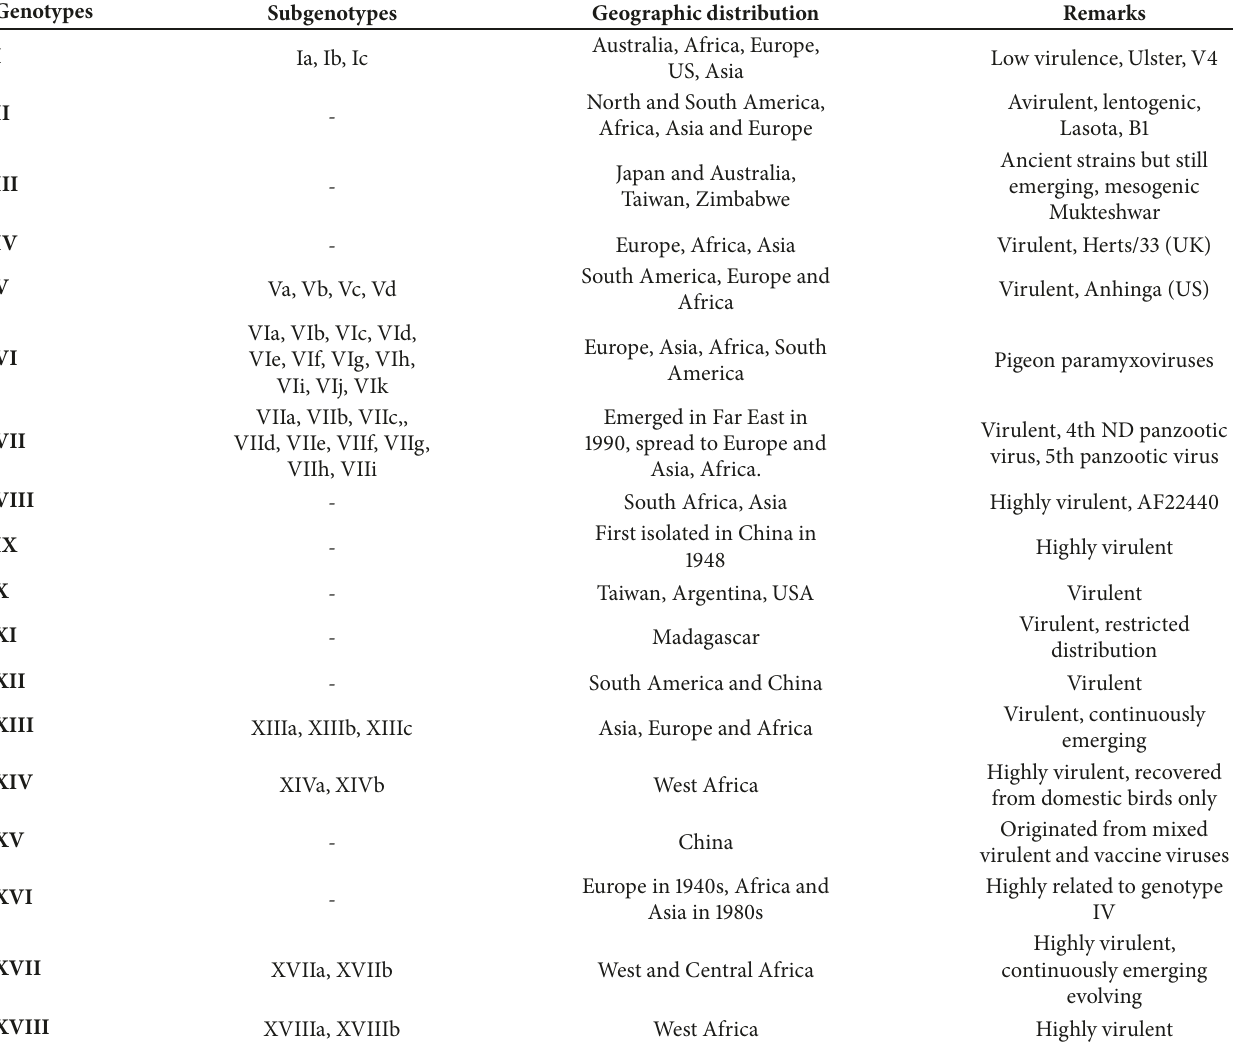
Table 1: Current classification and distribution of class II NDV